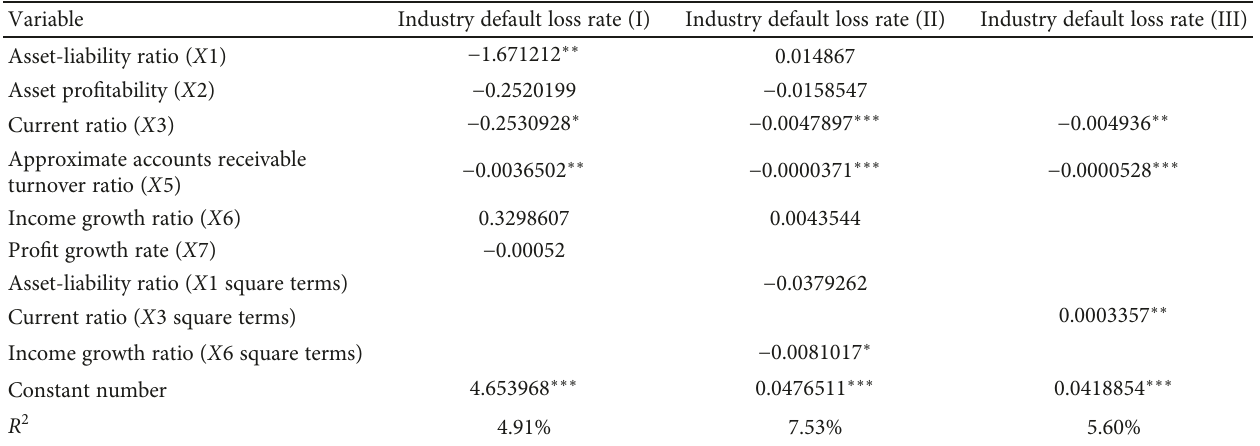
Table 2: Three model experimental evolution results.